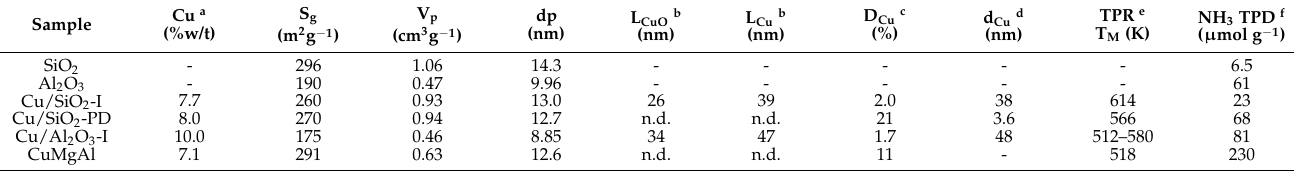
Table 1. Physicochemical characterization of the Cu-based catalysts and